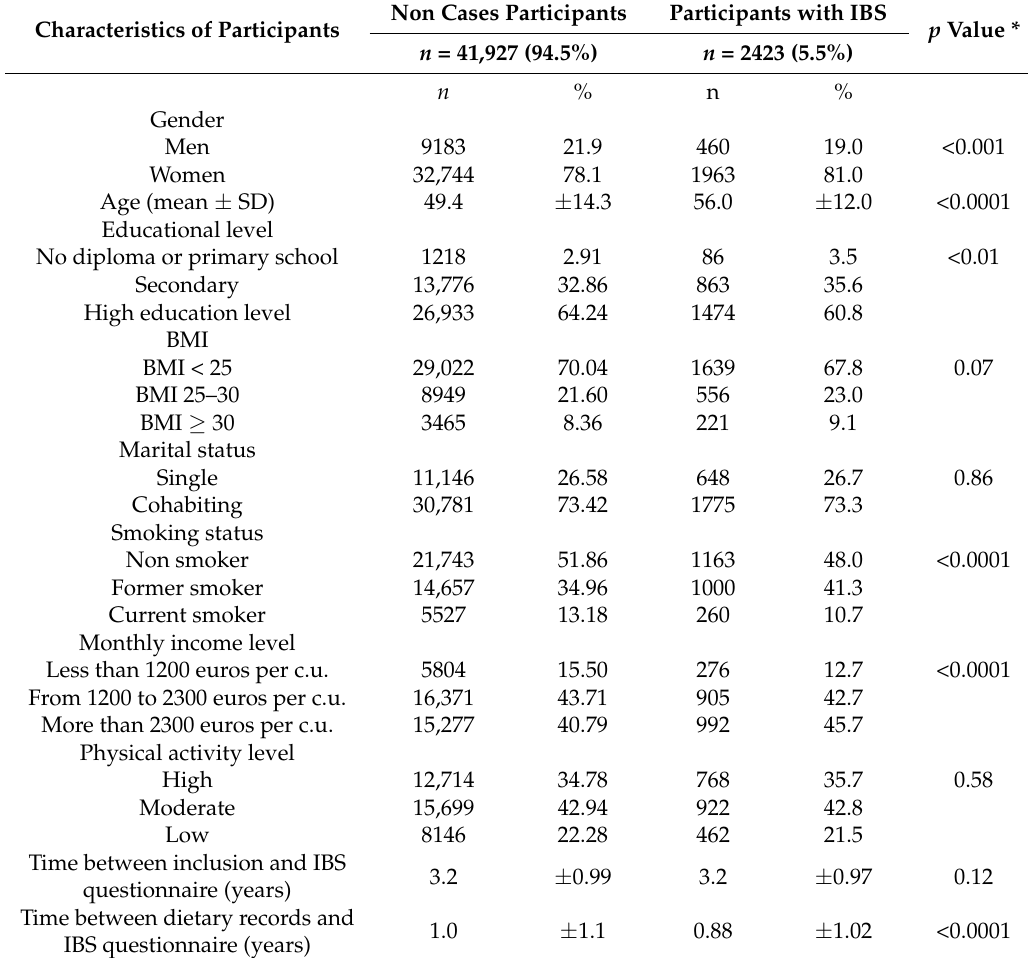
Table 1. Characteristics of participants according to the IBS ( n =